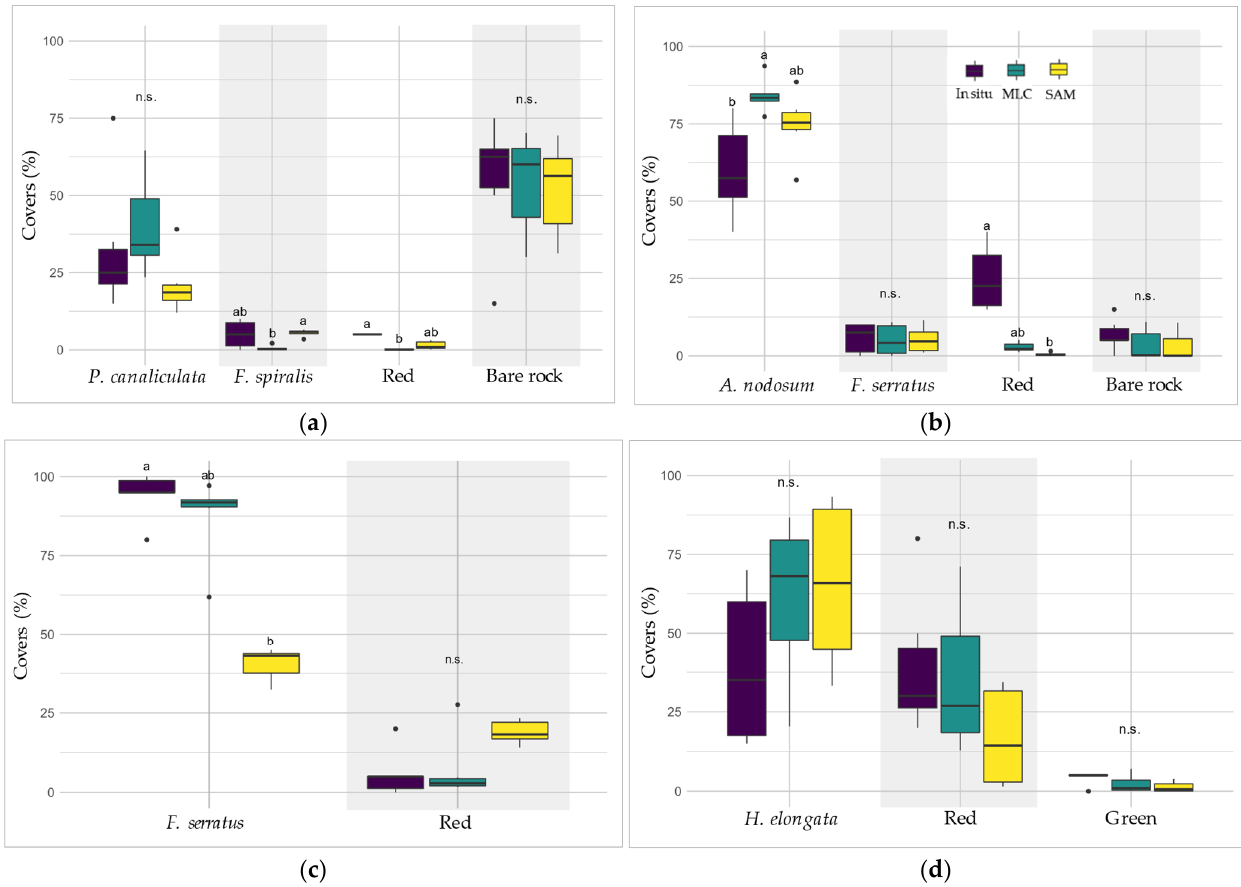
Figure 10. Db-RDA (scaling 1) performed from the macroalgal and pixels covers data for the in situ and the two classifications algorithms. Sampling spots are indicated by circles (Pc-Fspi = red circles, An = yellow circles, Fser = black circles and He-Ld = blue circles), variables (classes used in situ and for classifications: Pelvetia canaliculata , Fucus spiralis , Ascophyllum nodosum , Fucus serratus , Himan- thalia elongata , Red, Green and Substratum) appear in purple, and the explanatory variables (level: Pc-Fspi, An, Fser and He-Ld; method: in situ, MLC and SAM) in red.